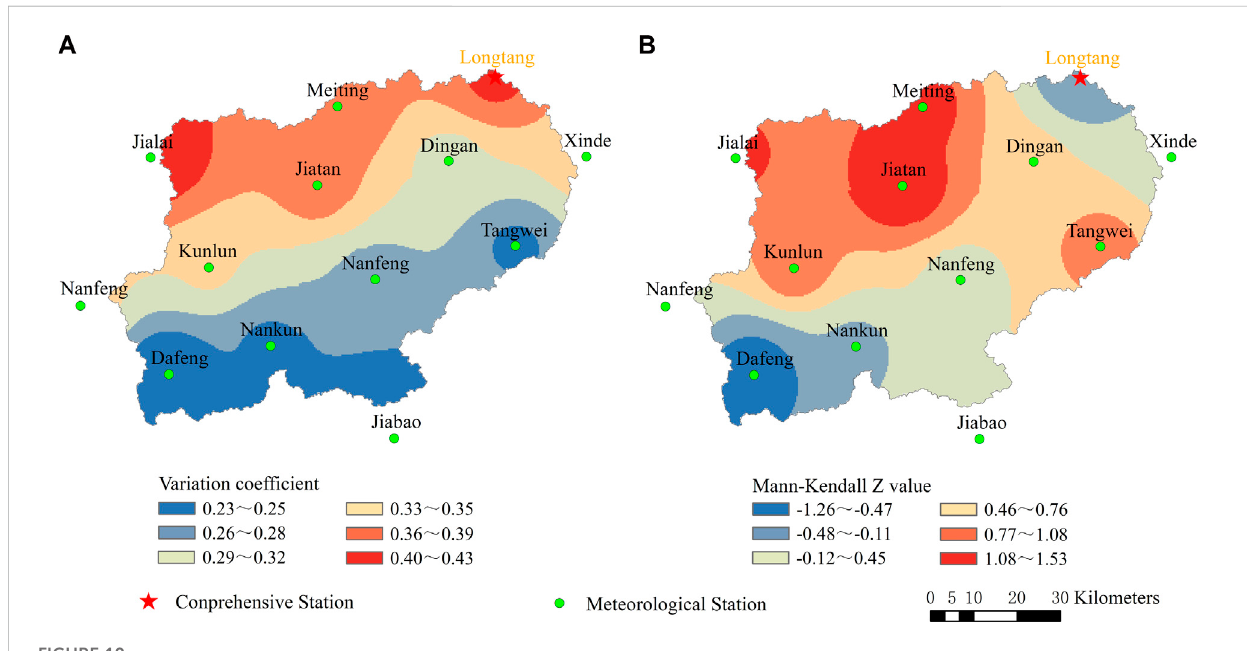
FIGURE 10 Spatial distribution of the coef fi cient of variation and Mann-Kendall Z value of rainfall erosivity in the Nandu River Basin.